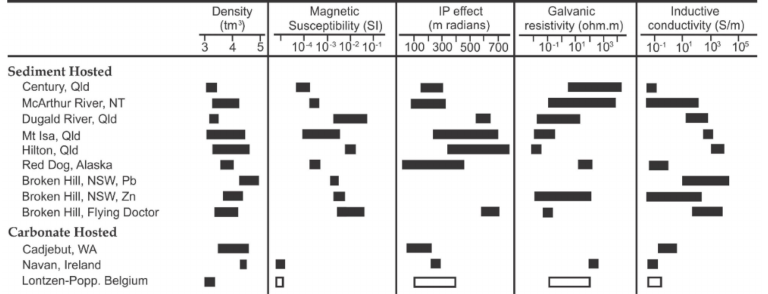
Figure 1. Petrophysical properties of Pb–Zn sedimentary ore deposits, represented by black rectangles (modified after [18]). Geophysical properties are represented by white